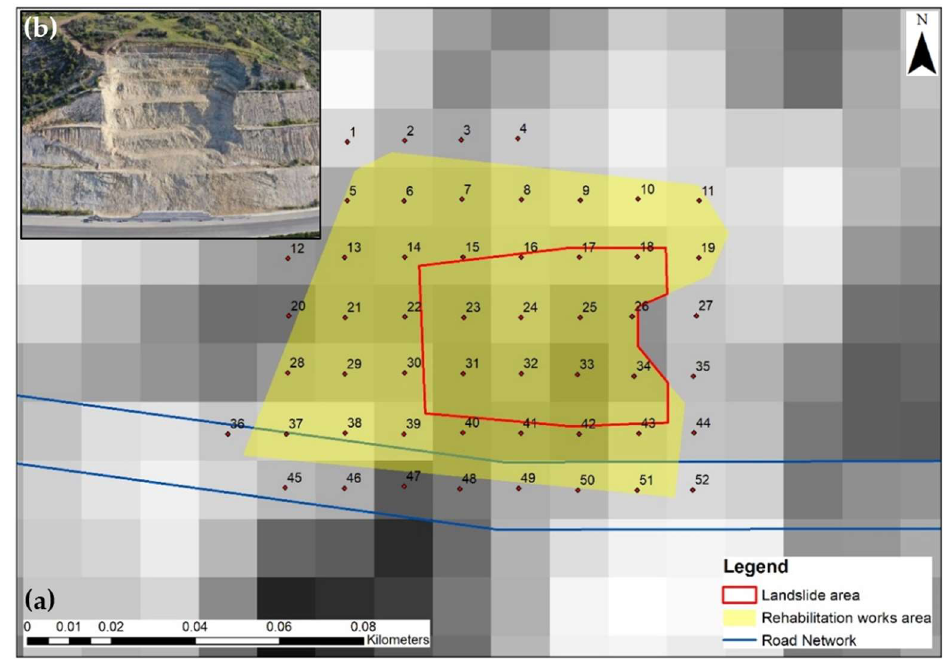
Figure 3. ( a ) Point grid used for the statistical analysis of the coherence values [29]. The red polygon outlines the extents of the area that was affected by landslide (AOI). The wider area of the rehabilitation works is marked in yellow and the A6 motorway is marked with blue line. ( b ) Site photo of the extent of the rehabilitation works at the embankment that was affected by the landslide [52].